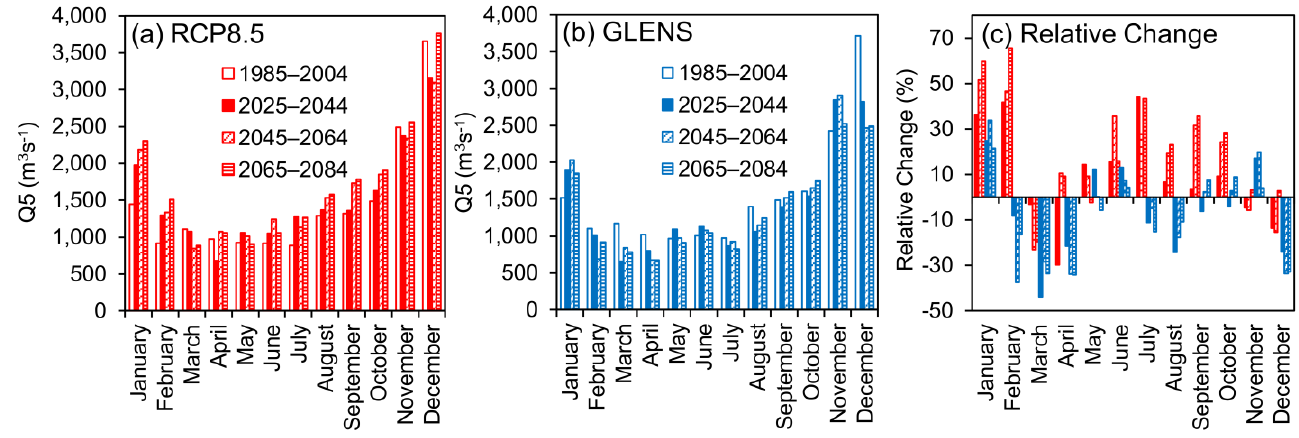
Figure 11. High flow (Q5) at the Jambatan Guillermard station under ( a ) RCP8.5 and ( b ) GLENS and ( c ) the relative changes of the 2025 – 2044, 2045 – 2064 and 2065 – 2084 periods from the 1985 – 2004 baseline period.